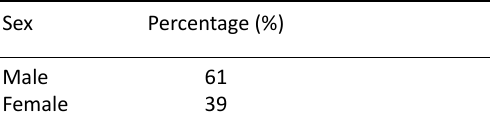
Table 3. Distribution of study population according